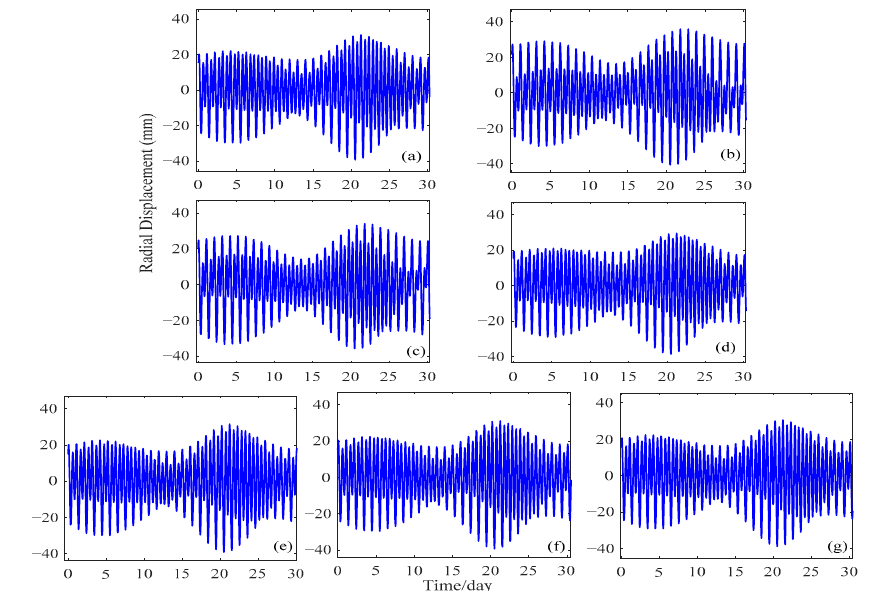
Figure 4. The magnitudes of vertical OTL displacement at the island station BRMU (Bermuda island, United Kingdom), determined using different OTL models: ( a ) DUT10, ( b ) EOT11a, ( c ) FES2004, ( d ) GOT4.7, ( e ) Hamtide11a, ( f ) Nao.99b and ( g ) TPXO7.2.